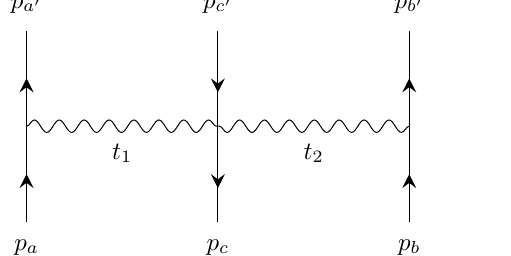
Figure 3. A schematic representation of the factorized three-to-three amplitude in eq.